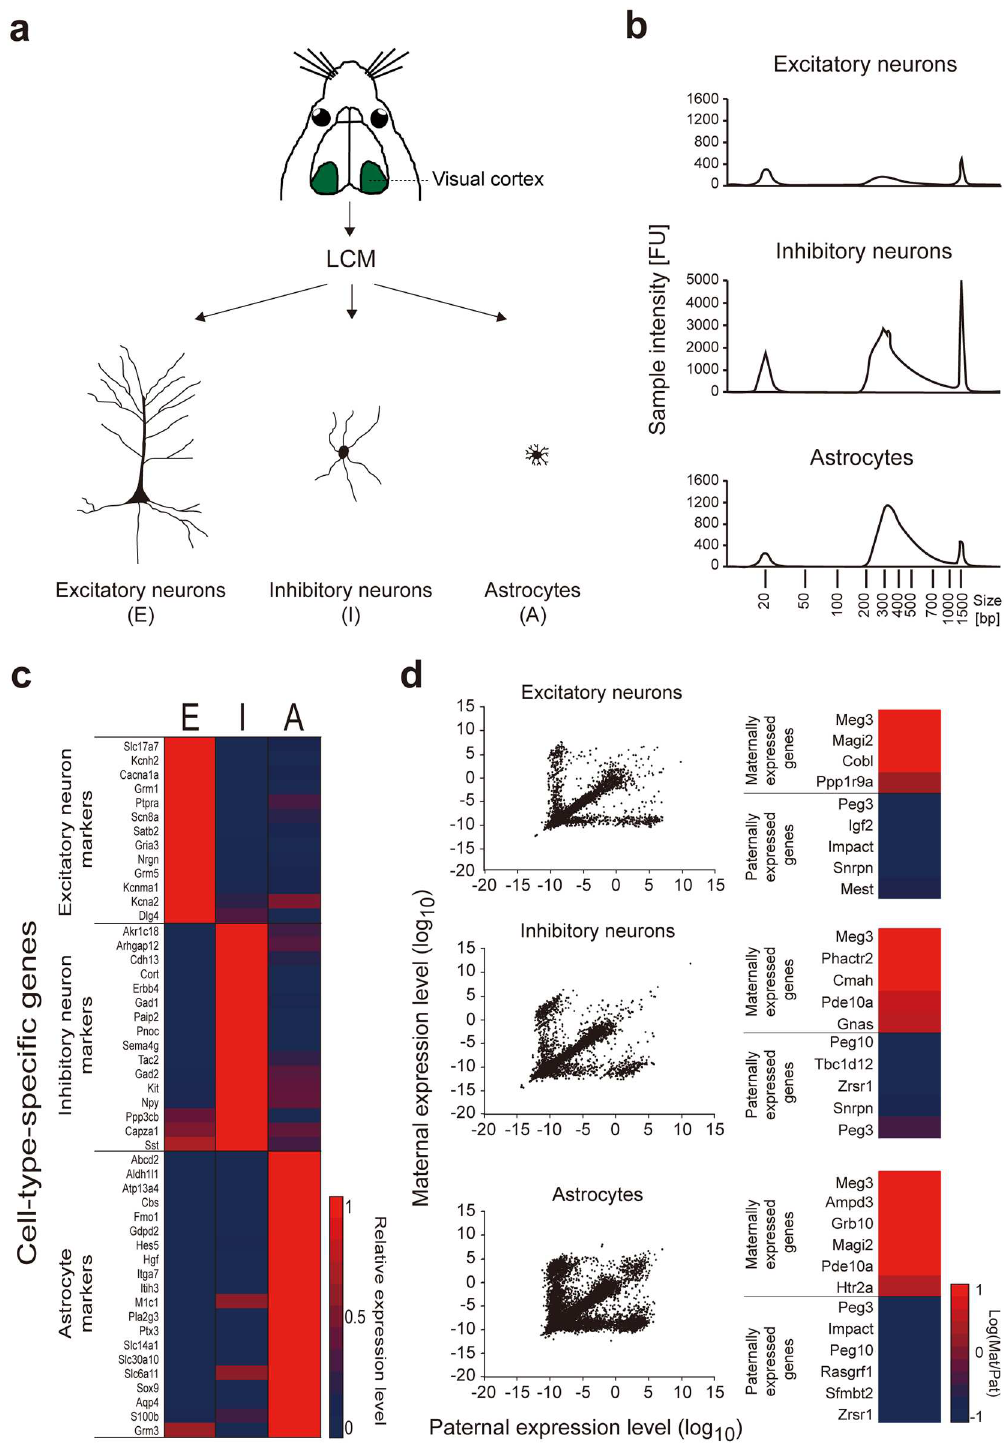
Fig 2. Cellular identity and genomic imprinting status were maintained in LCM-captured cells of mouse visual cortex. ( a ) Schematic diagramof the mouse visual cortex and the three cell types captured with LCM: excitatory neurons (E), inhibitoryneurons(I) and astrocytes (A). ( b ) Quality of the cDNA library was evaluatedby the fragment peak size and concentration of cDNA using the TS HS D1000 (Agilent) assay. Top: excitatory neurons; fragment peak size = 284 bp; concentration = 7 nM. Middle: inhibitoryneurons; fragment peak size = 293